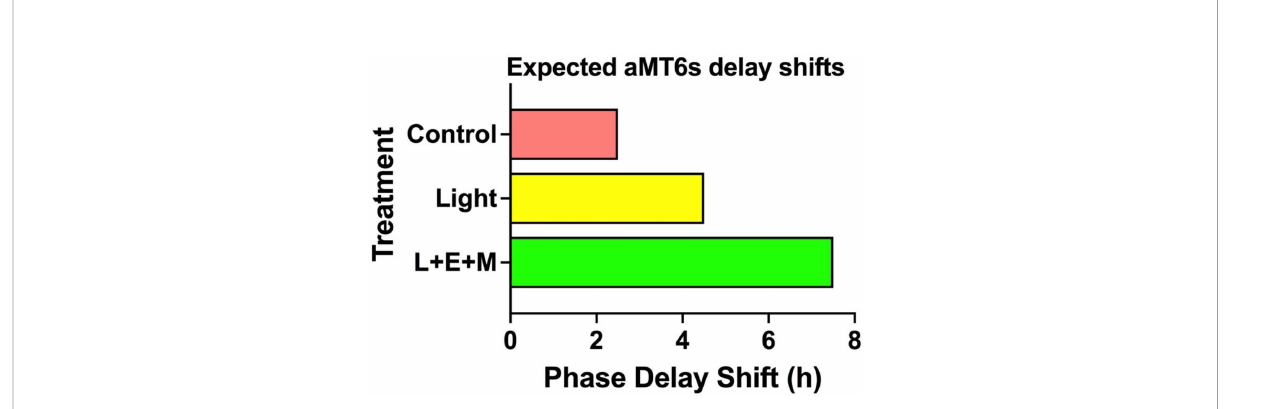
FIGURE 5 Expected delays in aMT6s phase markers after 3 days of treatment. Compared to corresponding baseline phase we expect delays of 2.5 h the control group, 4.5 h with bright light alone and 7.5 h in the light + exercise + melatonin treatments. Shifts in the our two aMT6s phase markers, onset and acrophase, are expected to be equivalent and signi fi cantly